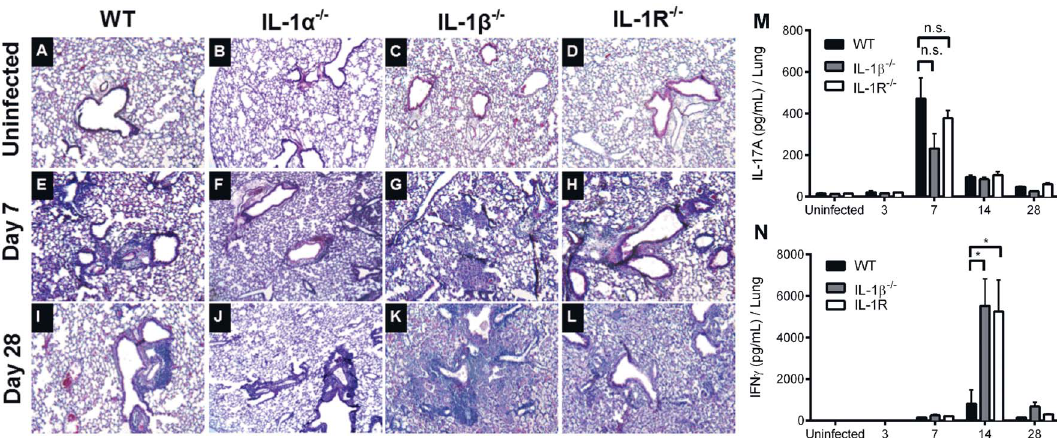
Figure 2. IL-1 signaling limits lung inflammation during B.pertussis infection. Groups of four mice were either (A–D) uninfected or inoculated with B. pertussis and euthanized at (E–H) 7 days or (I–L) 28 days post-inoculation. Automated H&E staining was performed on 5 m m paraffin-embedded sections. Images were taken and are representative of 10–12 fields per group. Lung homogenate cytokine measurements (M–N) were measured by ELISA from uninfected mice or on days 3, 7, 14, or 28 post-inoculation (n=4–8). ELISA significance was determined by one-way ANOVA with Dunnet’s post-hoc test. *p , 0.05 represents a significant difference from WT mice.